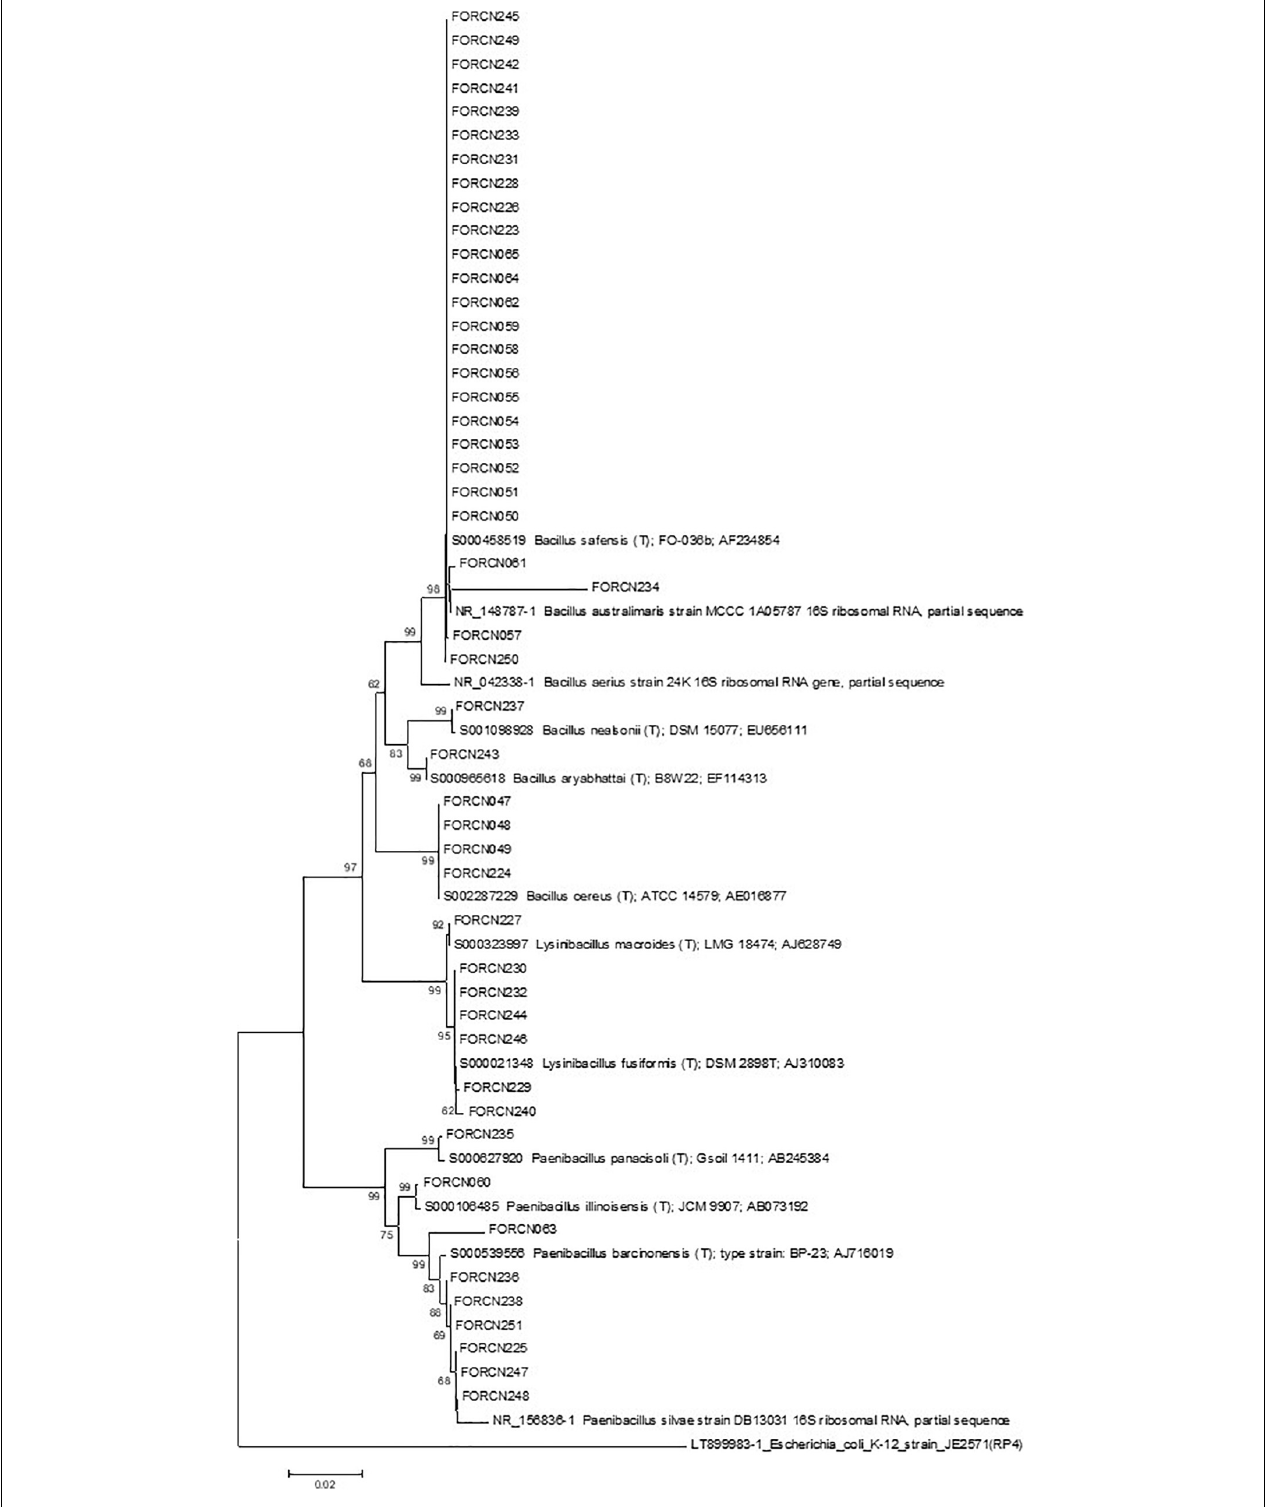
FIGURE 5 | Phylogenetic relationships of isolated bacteria from the digestive tract of the giant borer estimated by 16S rRNA sequence. The tree was obtained using the Neighbor-Joining (NJ) statistical method and the Kimura 2-parameter model as indicated by the model test function of the MEGA 7.0 program. Bootstrap values are shown when the represented relationships have been observed in at least 50% of 1000 replicates. The scale bar represents the number of base pair substitutions per site. Escherichia coli was used as an external group.